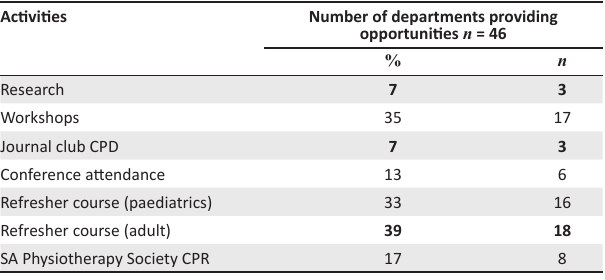
TABLE 3: Cardiopulmonary physiotherapy development opportunities provided by physiotherapy departments.